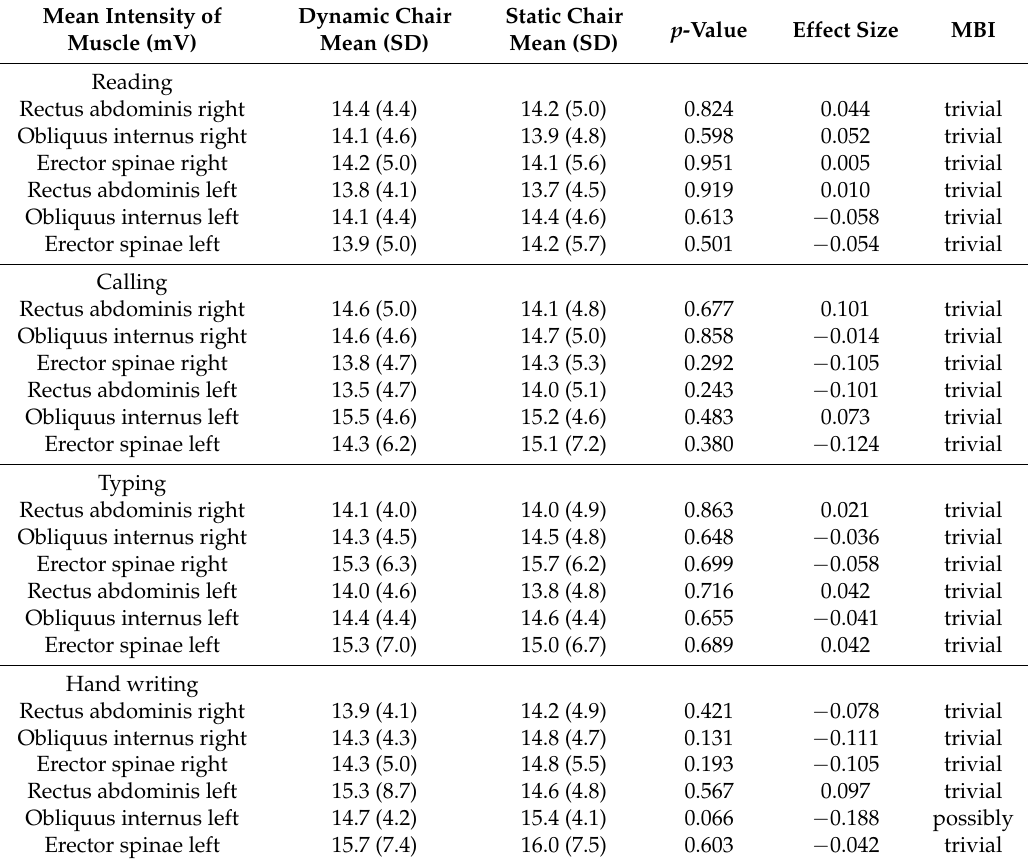
Table 2. Mean (1 standard deviation) mean muscle intensity while sitting on the static or dynamic chair performing the different